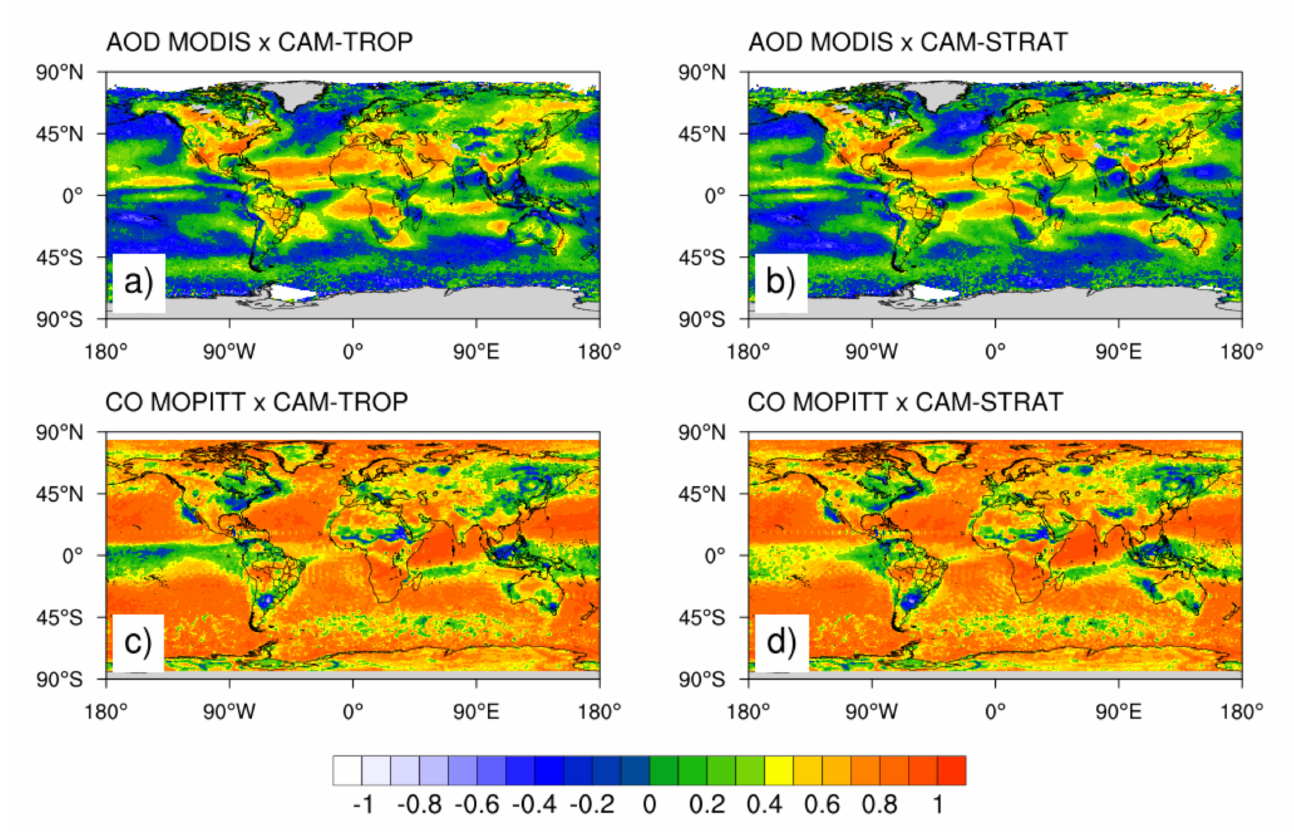
Figure 11. Correlation maps between the annual average of observed and simulated AOD ( a , b ) and CO (ppb) ( c , d ) in both model